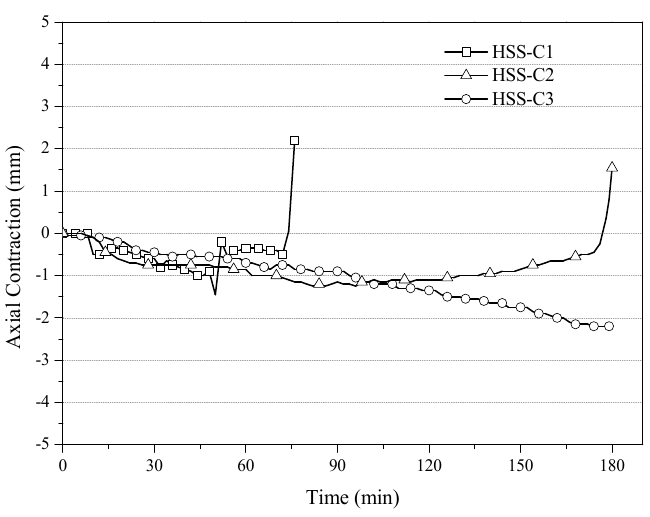
Figure 14. Temperature profiles at the top section for HSS-C3.